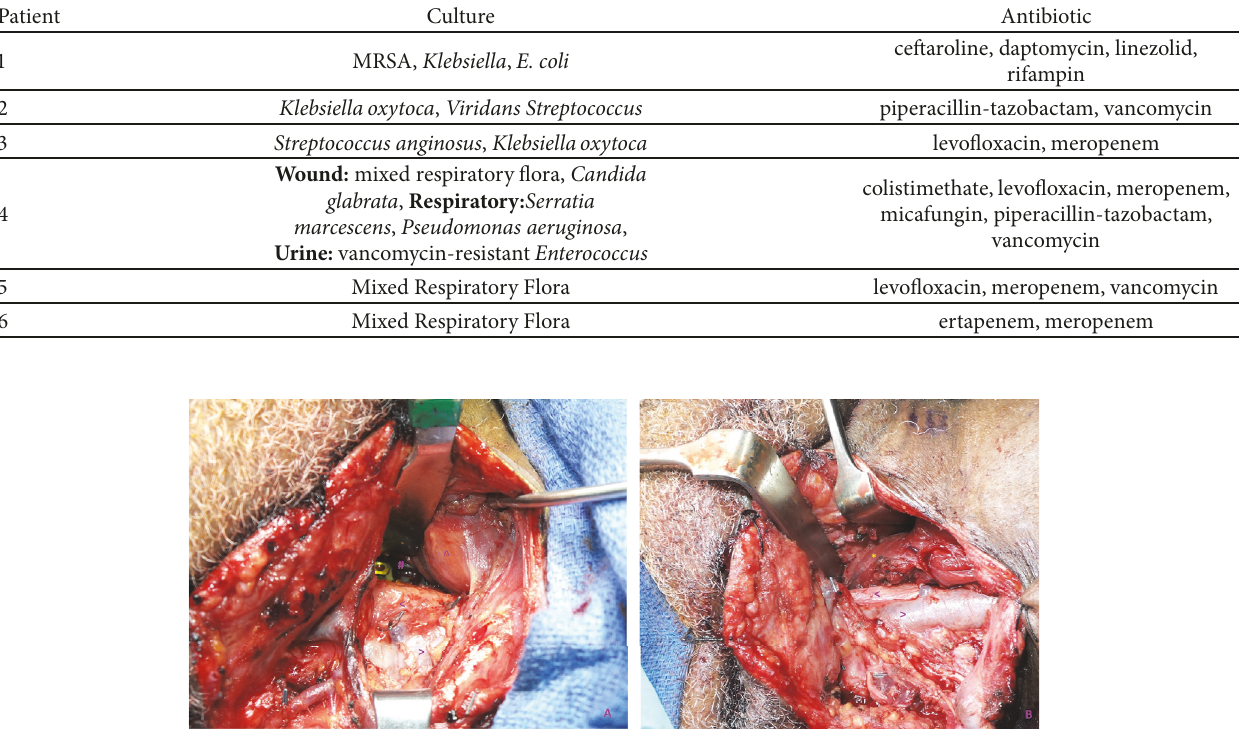
Figure 1: (a) Right neck with spine hardware (#) exposed with pharynx and esophagus ( ∧ ) being retracted medially. Common carotid artery ( < ) and internal jugular vein ( > ) are seen. (b) Inferiorly based SCM flap ( ∗ ) covering the spine hardware and reinforcing the pharynx and esophageal